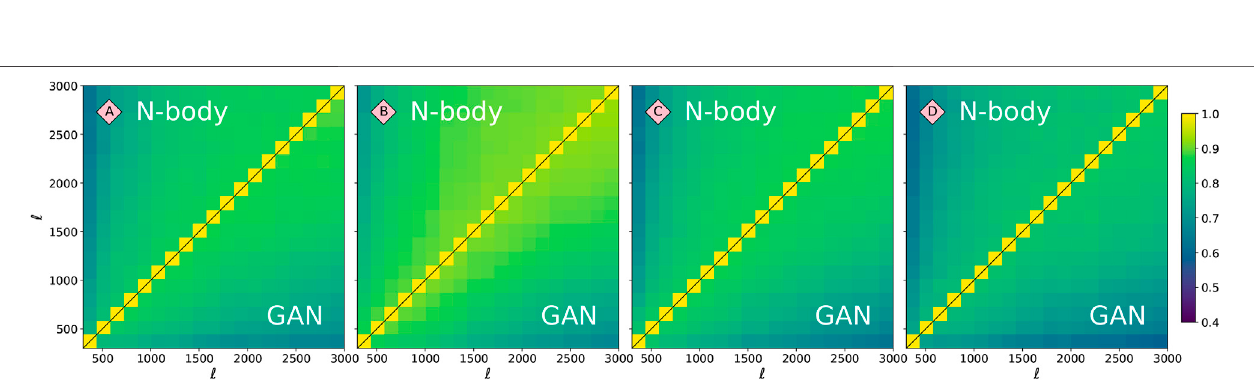
FIGURE 8 | Pearson ’ s correlation matrices for the four models highlighted in Figure 2 . The upper triangular corresponds to the original N-body power spectra, while the lower triangular to the power spectra of GAN-generated images. The fractional difference of the Frobenious norms ( Eq. 3 ) of these matrices is f R (cid:2) 0.02, 0.14, 0.06, 0.06, for models A, B, C, and D,